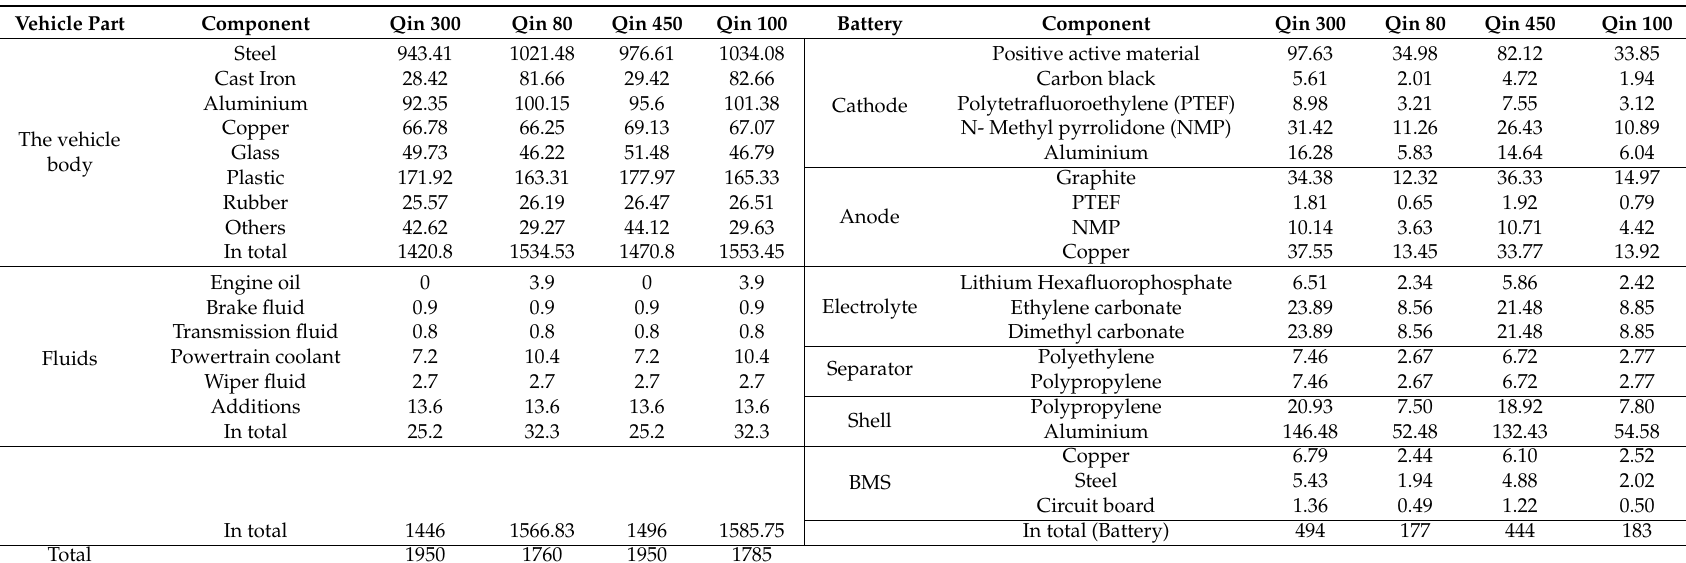
Table 3. The material component and the mass percentage of each vehicle technology (Unit: